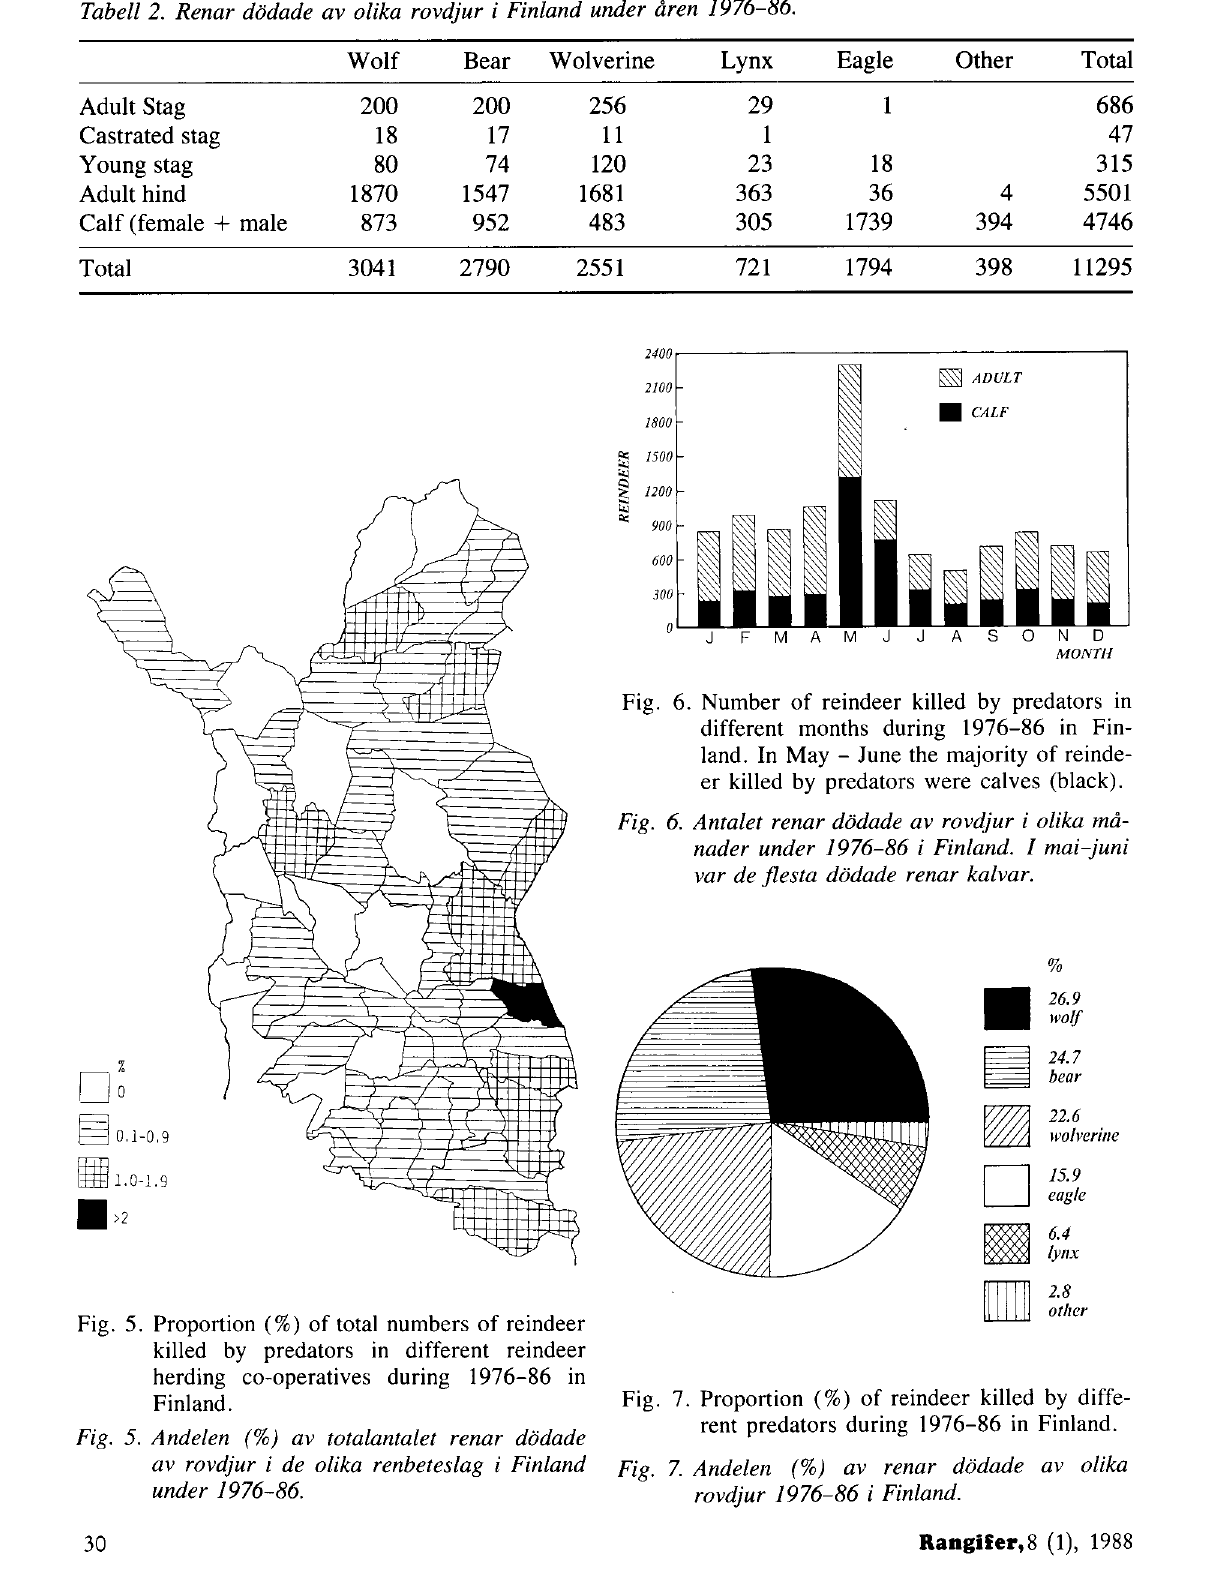
Table 2. Reindeer killed by various predators during 1976-86 in Finland. Tabell 2. Renar dodade av olika rovdjur i Finland under åren 1976-86.